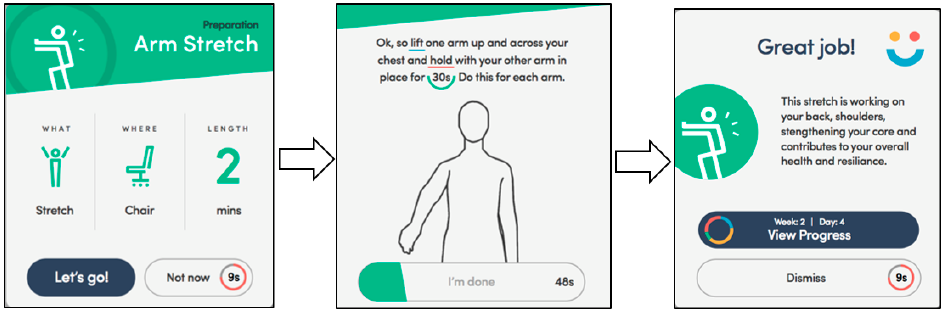
Figure 1. Example of nudge delivered in the intervention (Note: Permission to include this Figure was granted by Welbot